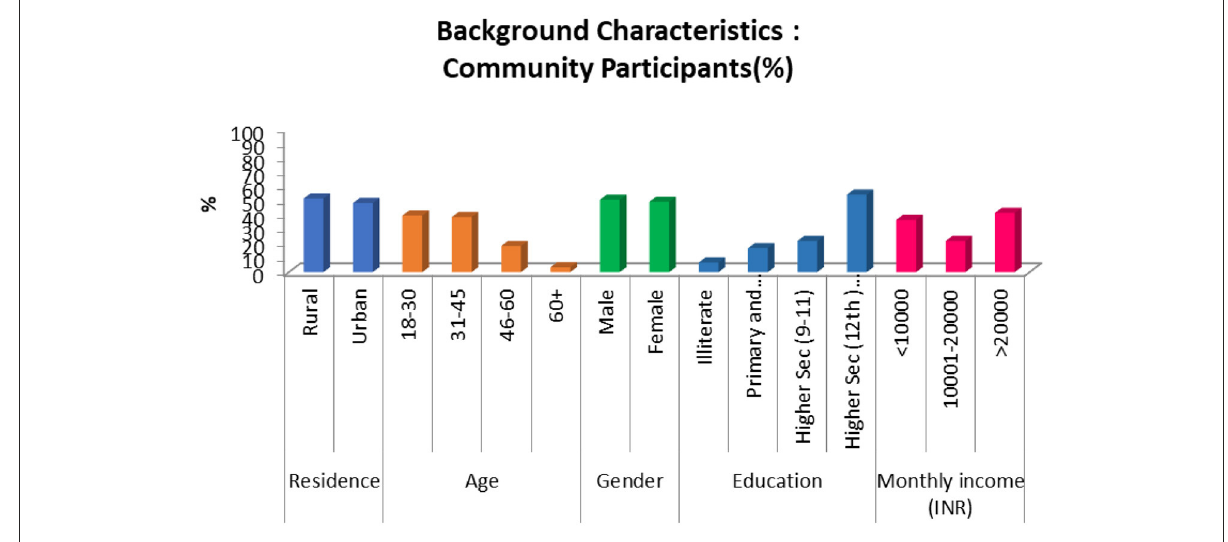
FIGURE1 Socio-demographic characteristics of community participants.